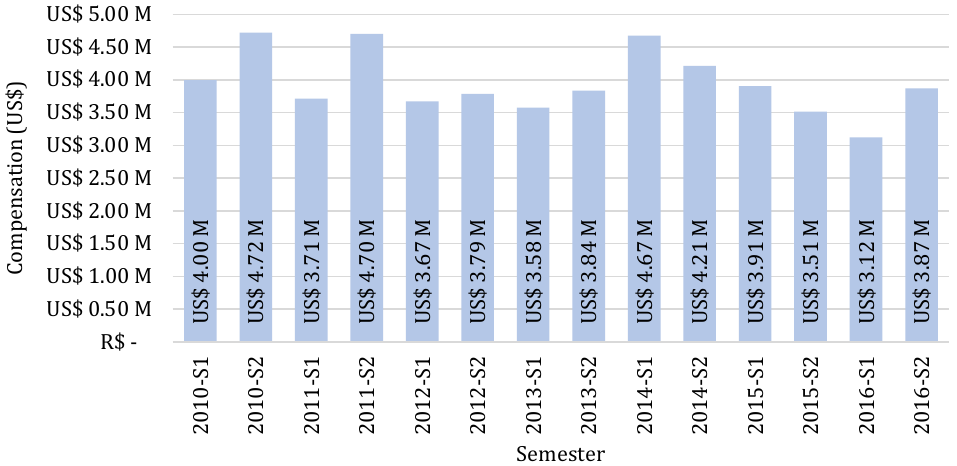
Figure 5. Semiannual evolution of compensation for poor quality in Peru . Figures 6 and 7 present the values calculated for continuity indicators in Uruguay, considering in a single grouping all consumers in the country, disaggregating into urban and rural connected to LV or MV and consumers directly connected to ST [71]. Thus, it appears that consumer groups located in rural areas are more affected by supply interruptions.